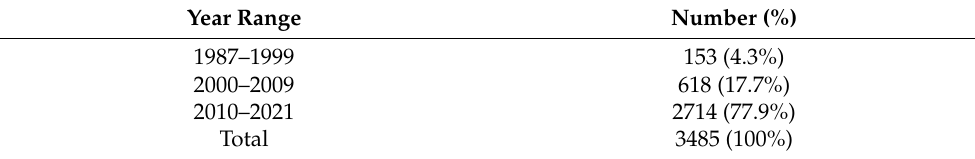
Figure 5. The number of the articles by publication years. Table 3. Research trends by